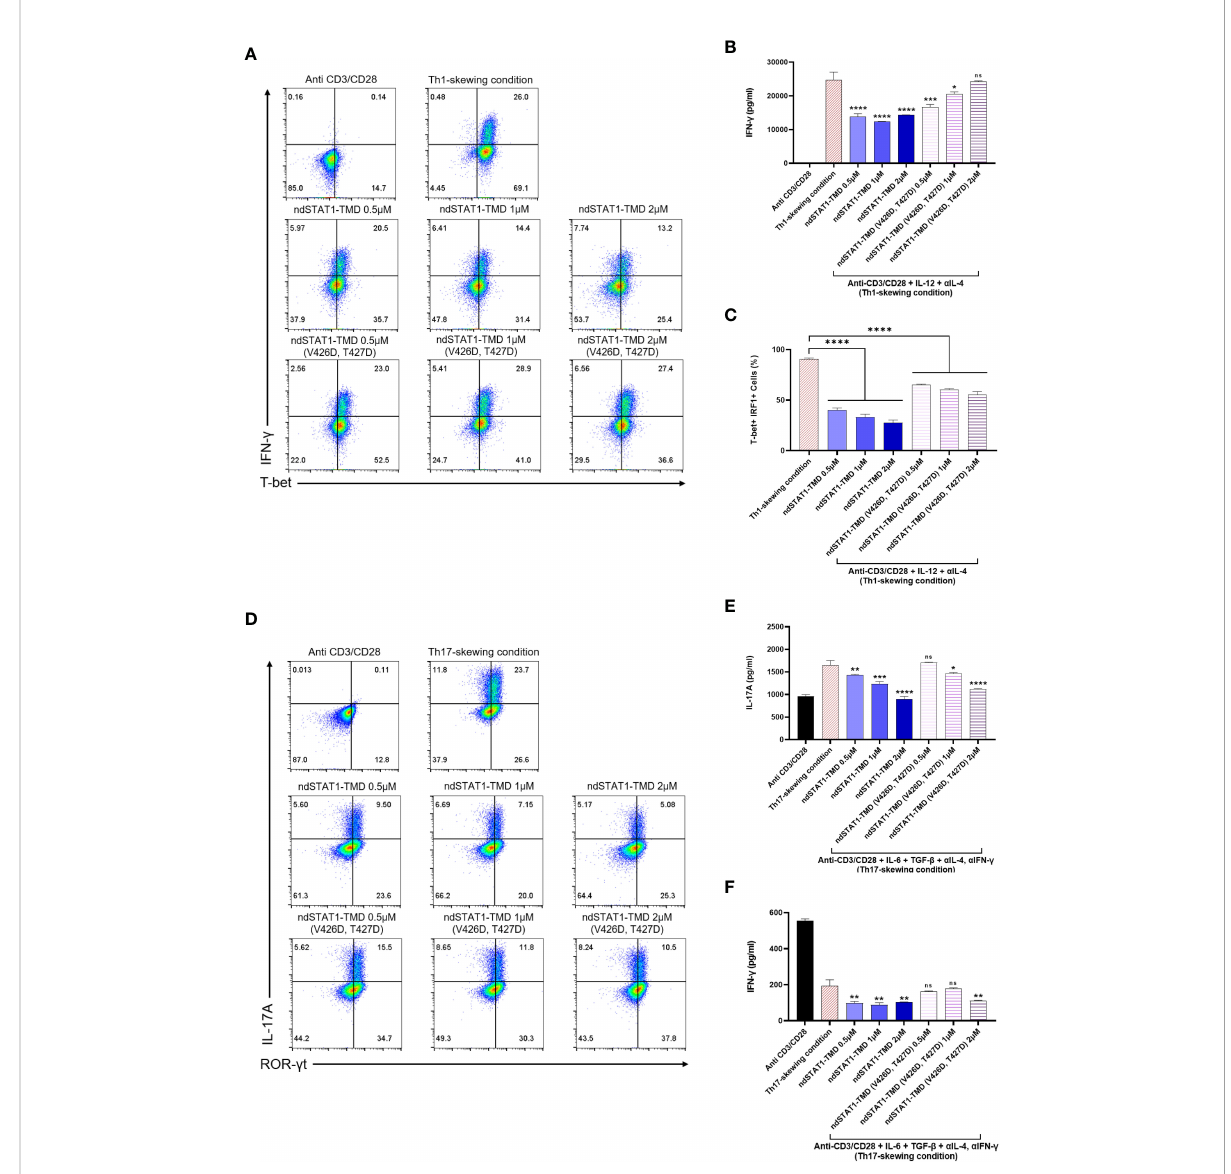
FIGURE 2 The functional in fl uence of ndSTAT1-TMD on differentiation capacity of CD4 + naïve T cells into various T cell subsets. (A) Flow cytometry analysis of intracellular T-bet and IFN- g in Th1 cells treated with different concentrations (0.5-2 m M) of ndSTAT1-TMD or ndSTAT1-TMD (V426D, T427D) under Th1-skewing condition. (B) The level of the secreted IFN- g in the supernatant from Th1 cells in (A) was measured by ELISA. (C) The level of T-bet + IRF1 + cells in Th1 cells in (A) was analyzed by fl ow cytometric analysis. (D) Flow cytometry analysis of ROR- g t and intracellular IL-17A in Th17 cells treated with different concentrations (0.5-2 m M) of ndSTAT1-TMD or ndSTAT1-TMD (V426D, T427D) under Th17-skewing condition. (E, F) The level of the secreted IL-17A or IFN- g in the supernatant from the Th17 cells in (D) was measured by ELISA. All experiments shown here were repeated 3 times on independent biological samples with similar results. Data are represented as mean ± SEM (n ≥ 3), and the statistical analysis was examined using Student ’ s t-test. ns, not signi fi cant, *p<0.05, **p<0.01, ***p<0.001, and